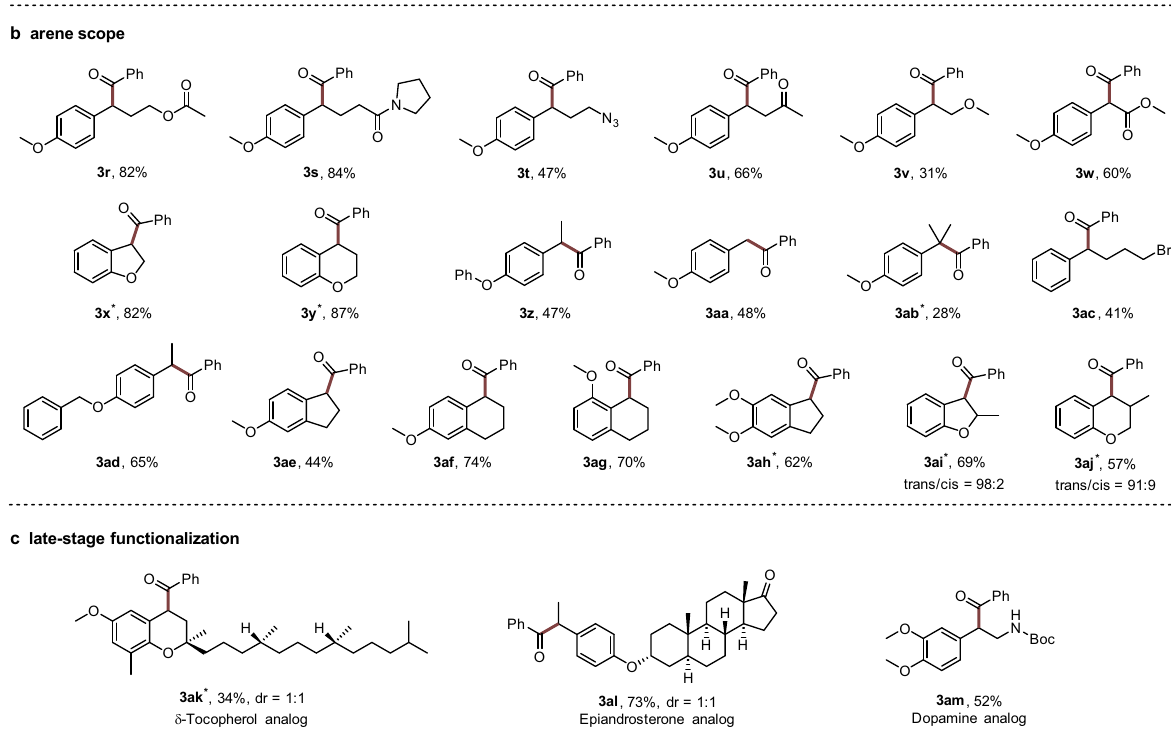
Fig. 3 The reaction scope. a Benzoyl scope. b Arene scope. c Late-stage functionalization. Reaction conditions: all the reactions were carried out with benzoyl fl uoride (0.4 mmol), arene (0.1 mmol), NHC precatalyst A (0.02 mmol), Cs 2 CO 3 (0.2 mmol), and 4CzIPN (0.002 mmol) in anhydrous CH 3 CN (0.6 mL), irradiation with blue LEDs at room temperature for 24 h. Isolated yields were given. * [Ir(dF(CF 3 )ppy) 2 (dtbbpy)]PF 6 (0.002mmol) was used instead of 4CzIPN. See SI for more details. 4CzIPN, 2,4,5,6-tetra(carbazol-9-yl)isophthalonitrile. LEDs light-emitting